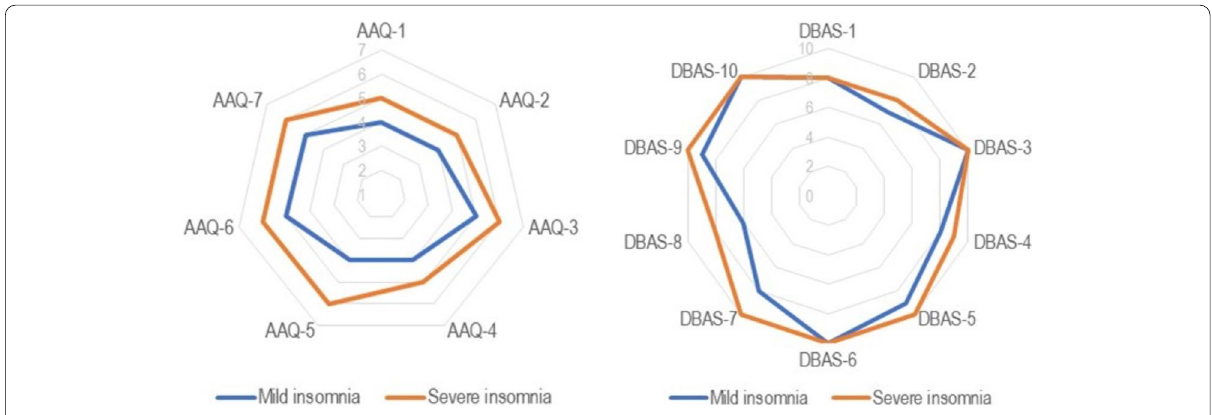
Fig. 1 Radar chart of median values of AAQ‑II and DBAS‑10 scores according to severity of